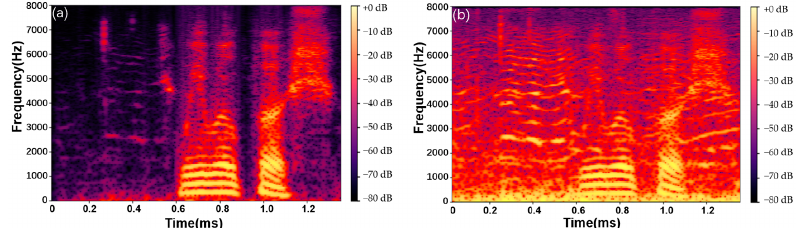
Figure 2. The spectrogram of ( a ) a clean speech signal and ( b ) a noisy speech signal.